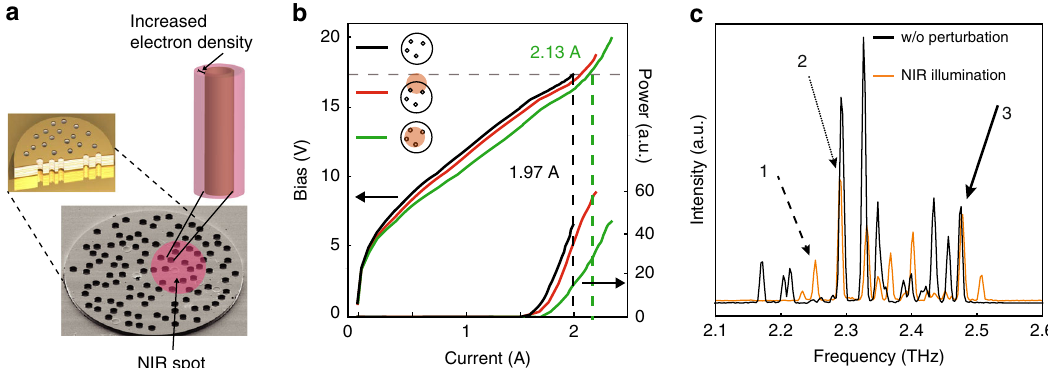
Fig. 1 QCRLs under NIR-spot scanning. a SEM picture of a QCRL with a NIR laser spot scanned across its surface (wavelength 813 nm, diameter 270 µ m, red circle). The QCRL (diameter 1 mm) is fi lled with holes (diameter 20 µ m) for a fi lling fraction of 18%. A schematic cross-section of the device is provided in the inset. The NIR light is absorbed and creates electron-hole pairs along the edges of the holes (right-hand-side schematic). The generated pairs produce a local increase in carrier density (red cylinder around the hole), which exponentially decays away from the hole. b Light – current – voltage characteristics of the QCRL without perturbation (black), for a spot in the center (green) and at the edge (red) of the sample (insets). Under a voltage bias of 17.5 V (horizontal gray dashed line), the current increases from 1.97 A (vertical black dashed line) to a maximum of 2.13 A (vertical green dashed line) due to photoexcited electrons. c Spectra measured in the absence of the perturbation ( “ w/o perturbation ” , black curve) and in the presence of the NIR perturbation spot ( “ NIR illumination ” , orange curve) at position ( x , y ) = (6, 9). The mode structure is in fl uenced by the NIR illumination. New modes emerge at seemingly arbitrary frequencies ( “ 1 ” , dashed line arrow), while existing modes are either attenuated ( “ 2 ” , dotted line arrow) or unaffected ( “ 3 ” , solid line